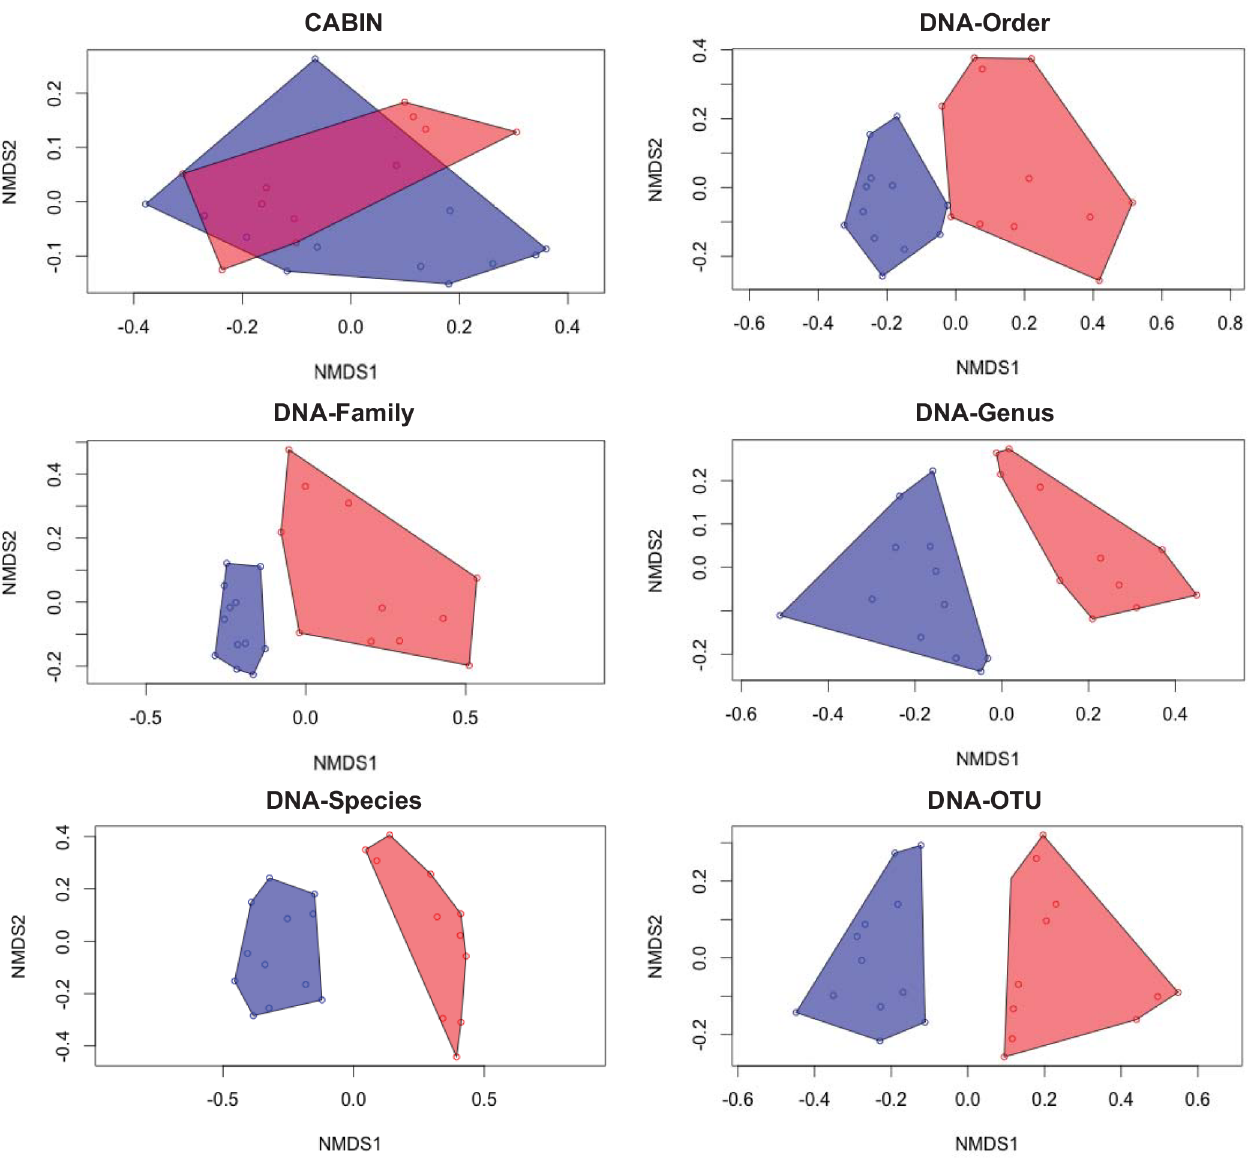
Fig 4. Community assemblage measures for 24 benthic samples from the Peace-Athabasca delta at six different taxonomic levels via morphological identification and HTS. Non-metric multidimensional scaling (nMDS) plots calculated from Bray-Curtis dissimilarities based on proportion of observations. Blue points and polygon represent Athabasca River sites. Red points and polygon represent Peace River sites.